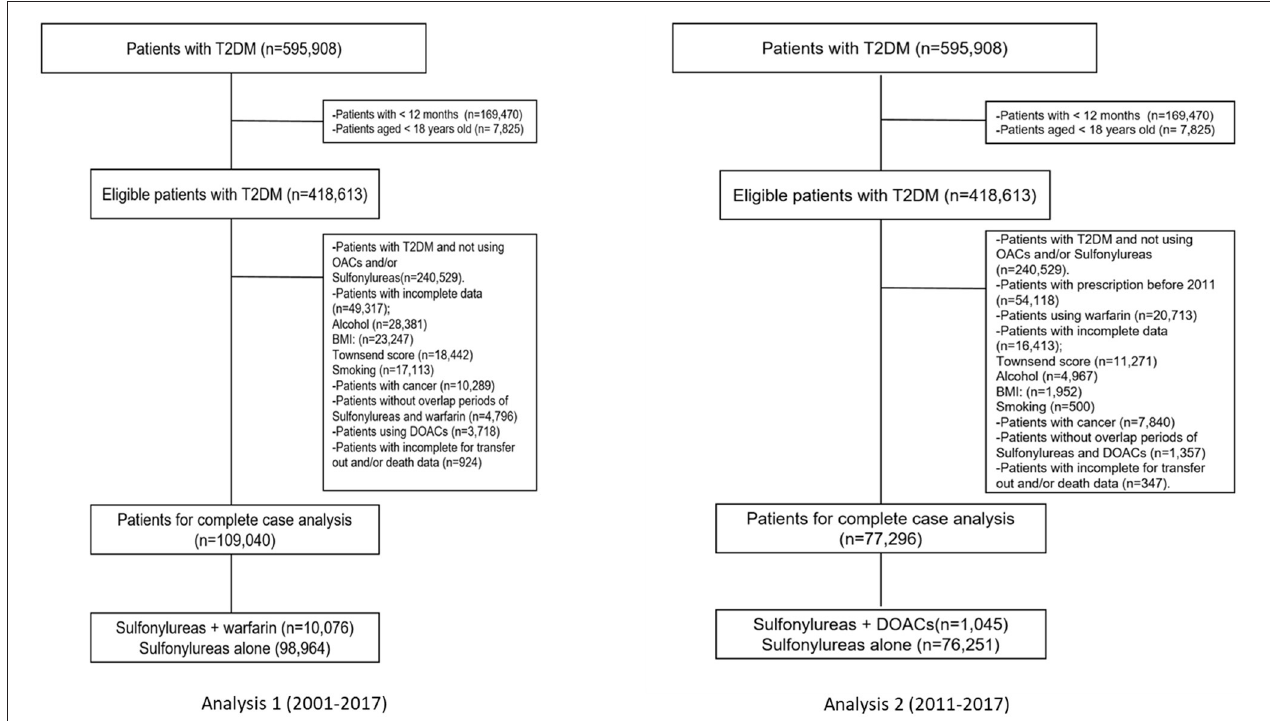
FIGURE 1 | Flow chart of the study